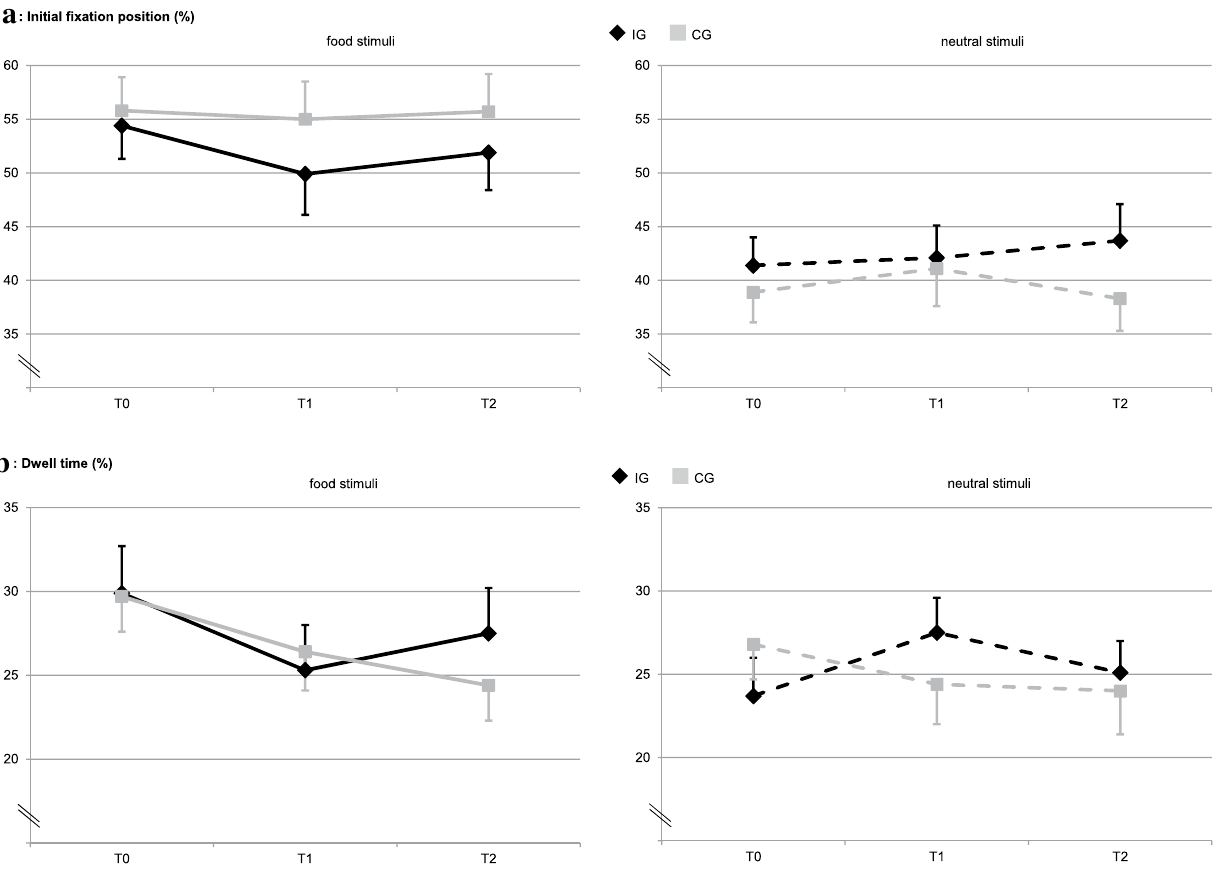
Figure 3. Eye tracking data of the cued exploration paradigm. Panel (a) : M (SE) of the initial fixation position (%), and Panel (b) : M (SE) of the dwell time (%) for food and neutral stimuli by treatment group (IG, CG) and measurement point (T0, T1, T2). Significant effects after Bonferroni correction with p < .025: In panel (a) , there is overall a significant stimulus effect with p < .001. Within groups, this effect was significant at T0 (IG: p = .014, CG: p = .001) and at T2 in CG ( p = .002). In panel (b) , there was a significant three-way interaction with p =